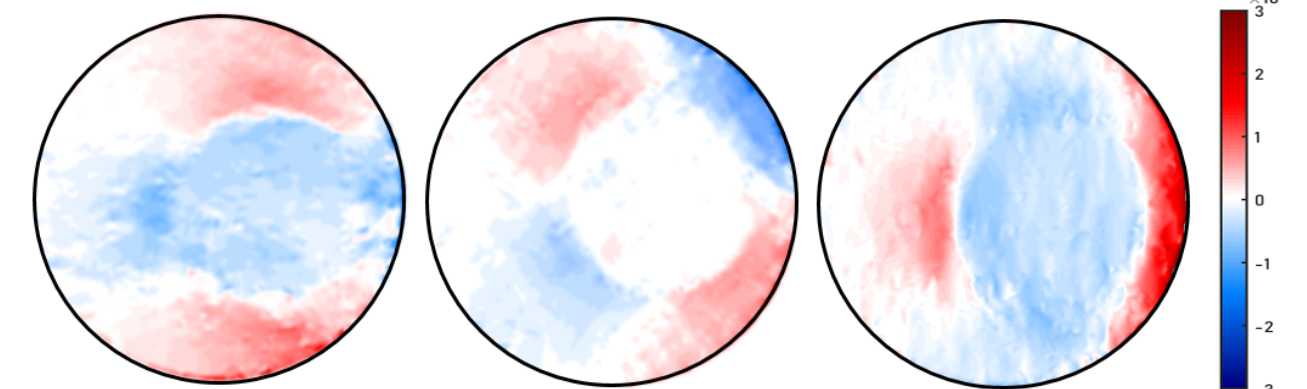
Figure 13. The reconstructed full-field two-dimensional strain components ( ε xx , ε xy , and ε yy ) with uniform node distribution.